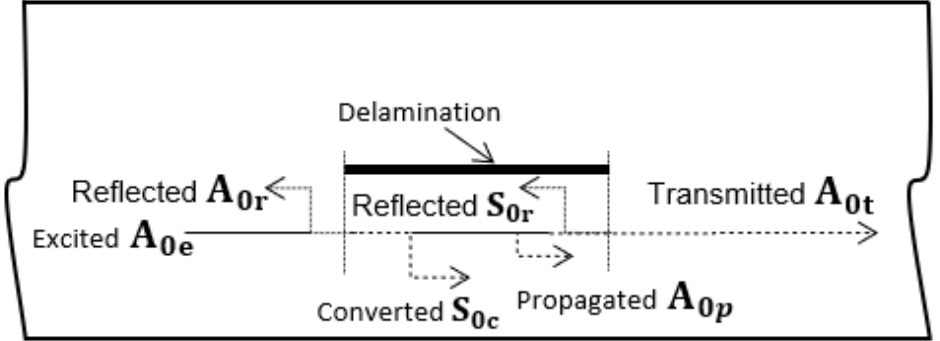
Figure 6. A 0 mode reflection and conversion at the leading and trailing edges of the delamination. The B-scans of the response of the guided wave A 0 mode to delamination at different positions (40 and 120 mm) in the longitudinal direction are presented in Figure 7. The propagation time of A 0 mode varies when the delamination position changes.